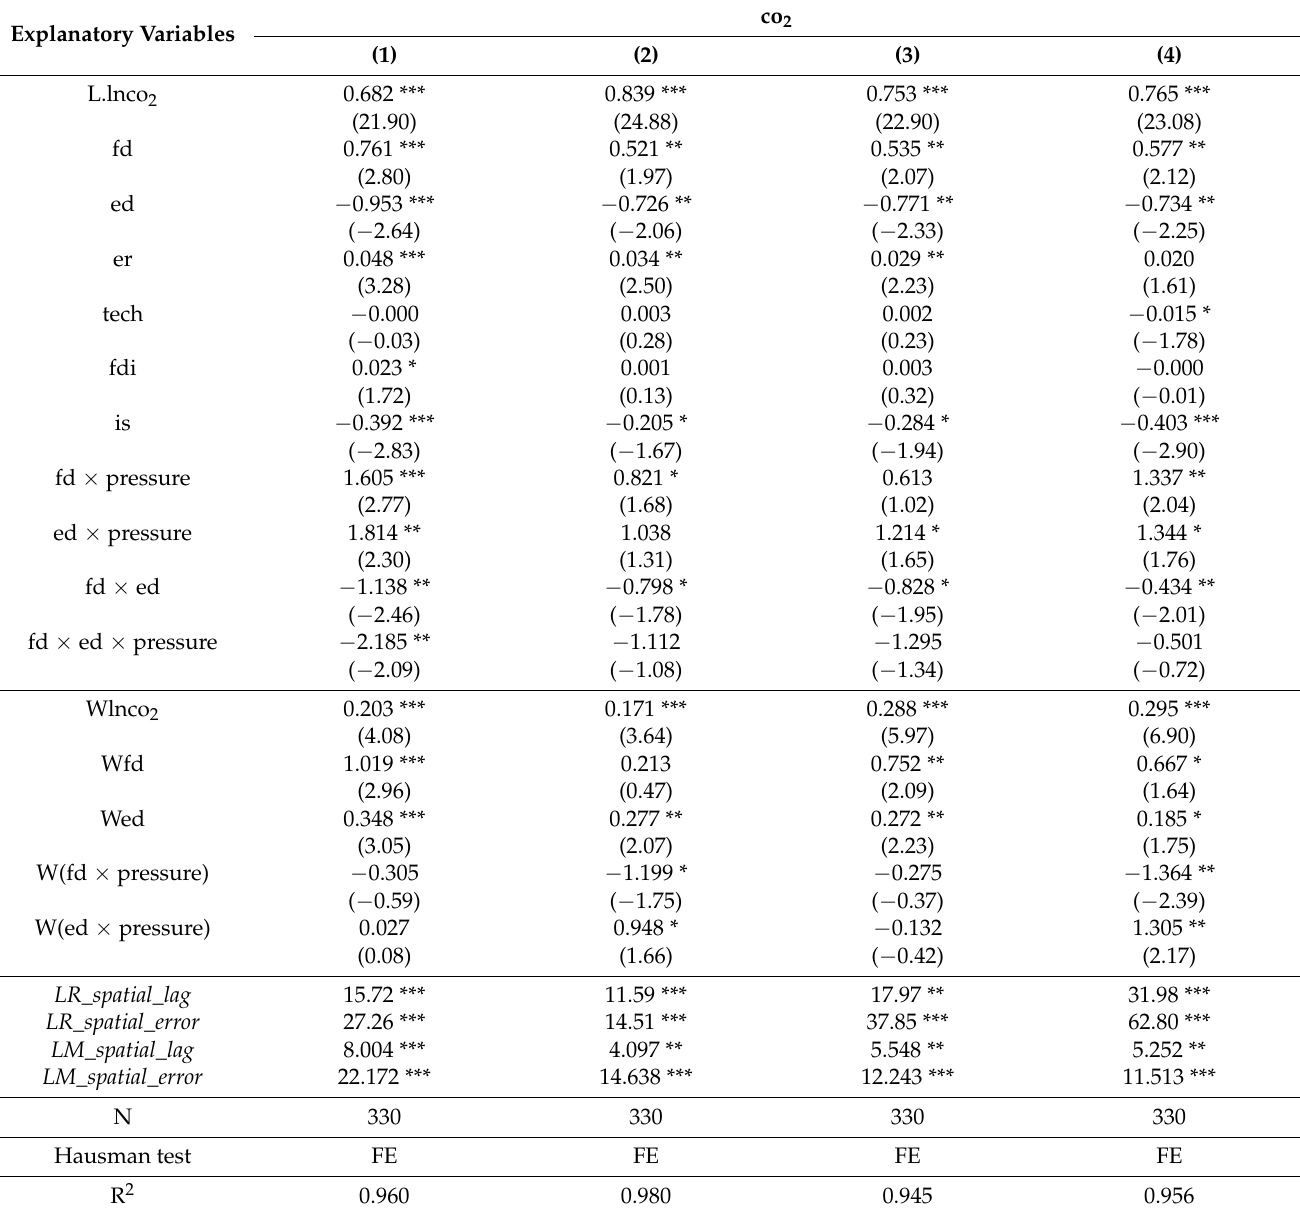
Table A2. Robustness testing of different measurement